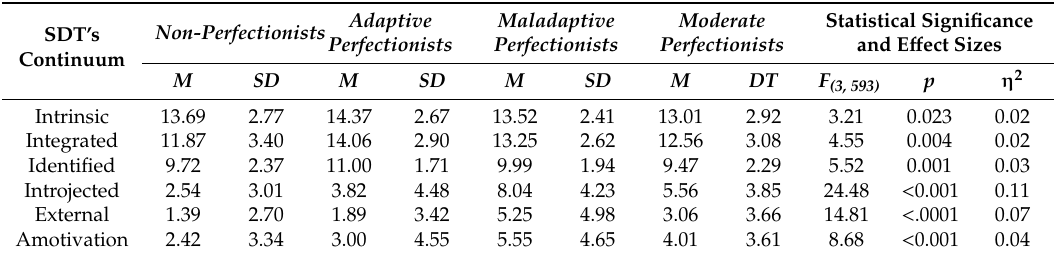
Table 3. Means, standard deviations, and inter-class statistic signification on the six regulatory styles. SDT’s Continuum